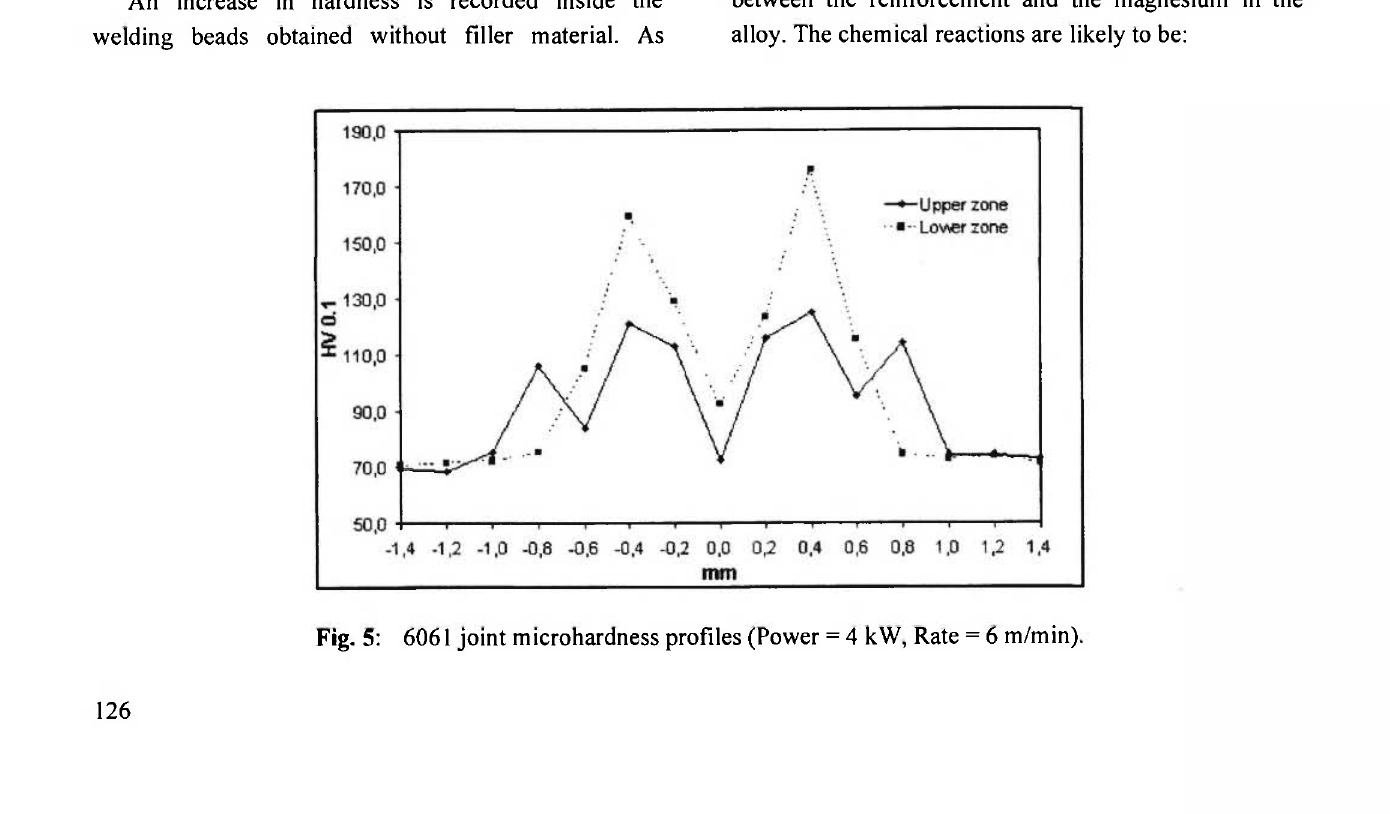
reported in Figure 5, the microhardness profiles, obtained for the 6061 welding bead at 0.1 mm from the surface of the sample (upper zone) and at about 3 mm from the surface (lower zone) show higher values in the welded zones than in the unaffected material. This increase in hardness appears higher especially in the lower zone. This behavior may be due to chemical reactions between the reinforcement and the magnesium in the alloy. The chemical reactions are likely to be: